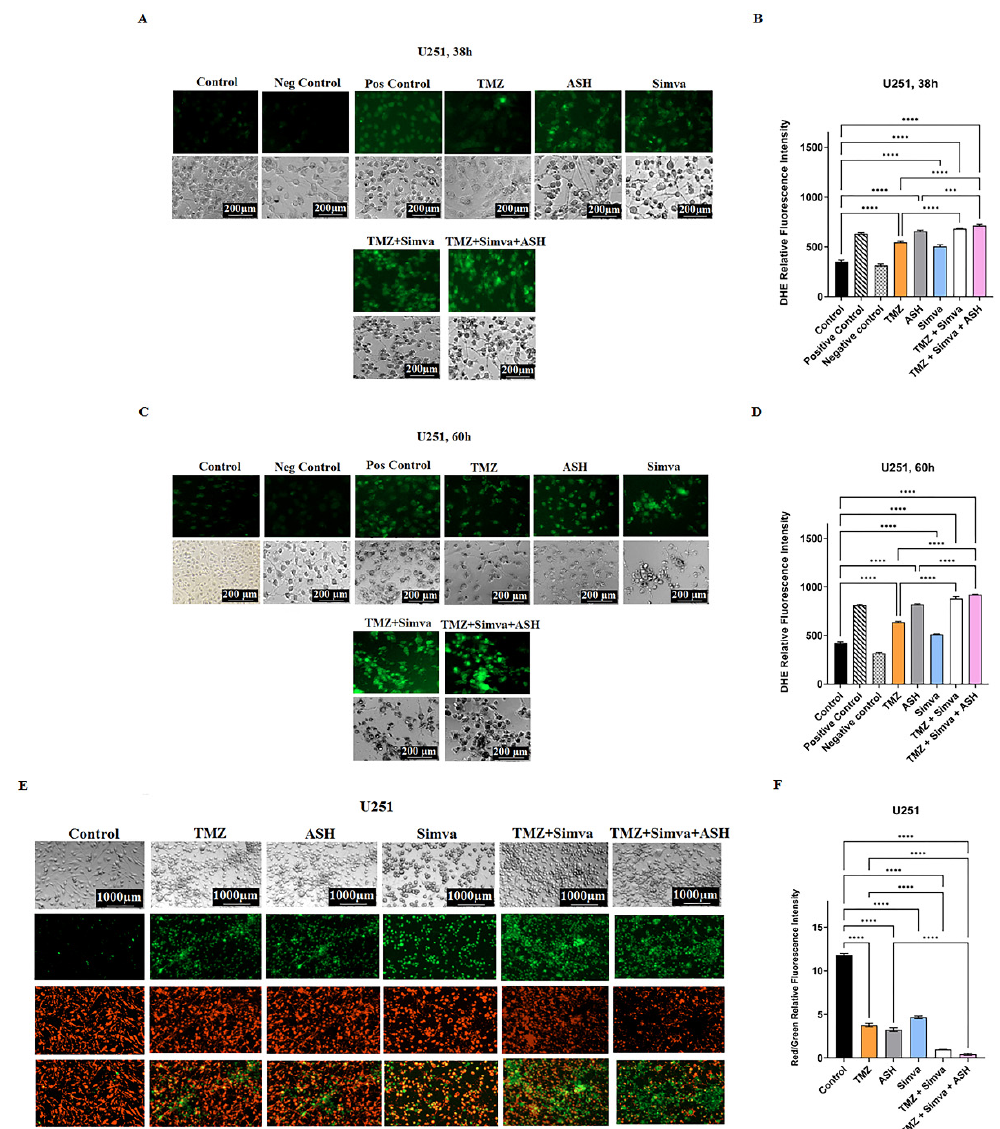
Figure 3. Simvastatin, temozolomide, acetylshikonin and their combination treatments induce mi ‐ tochondrial damage in human glioblastoma cells. U251 cells were treated with TMZ 100 μ M, Simva 1 μ M, ASH 1.5 μ M, TMZ/Simva and TMZ/Simva/ASH at two different time points (38 and 60 h). A Cayman ROS detection cell ‐ based assay (DHE) was used to assess levels of ROS under different conditions. All treatments induced a significant increase in ROS at both time points compared to the time ‐ match control (**** = p < 0.0001). Additionally, both combinations treatments (TMZ/Simva, TMZ/Simva/ASH) significantly induced more ROS compared to TMZ and ASH single treatments at both time points (38 and 60 h) (*** = p < 0.001; **** = p < 0.0001) ( A – D ). We also measured the mito ‐ chondrial membrane potential (MMP) in the U251 cell line. All treatments (TMZ 100 μ M, Simva 1 μ M, ASH 1.5 μ M, TMZ/Simva and TMZ/Simva/ASH) induced a significant decrease in MMP com ‐ pared to the time ‐ match control (**** = p < 0.0001) ( E , F ). Both combination treatments induced a decrease in MMP compared to TMZ and ASH single treatments (**** = p < 0.0001). All experiments have been done in three independent biological replicates.